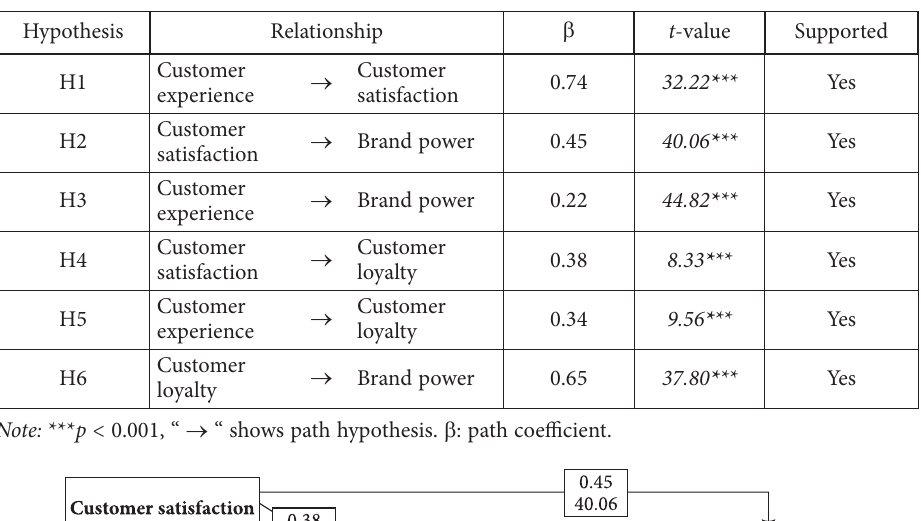
Table 4. Results of PLS analysis